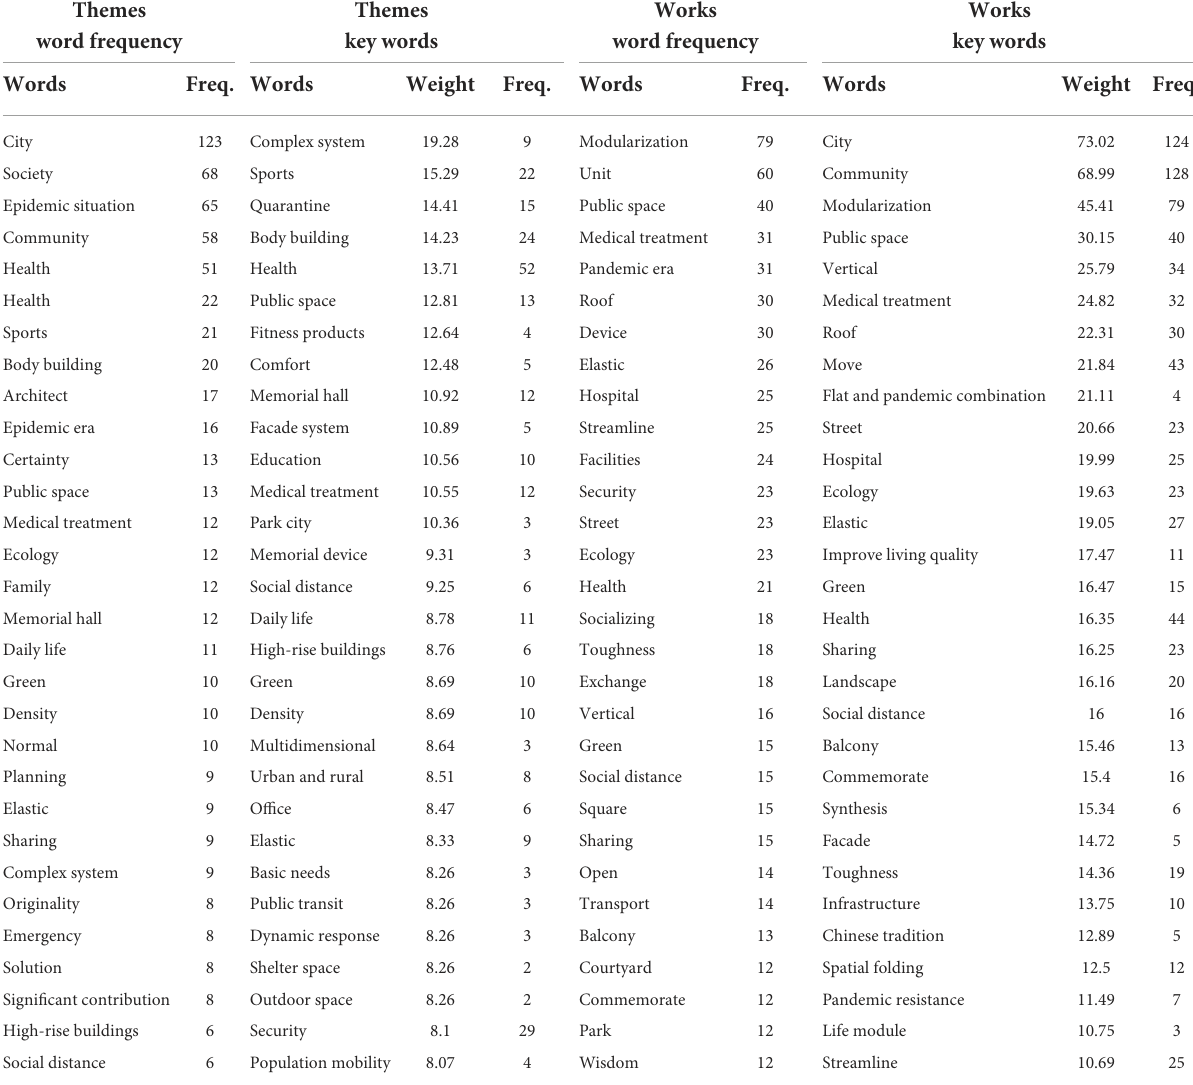
TABLE 1 High frequency vocabulary of competition themes and